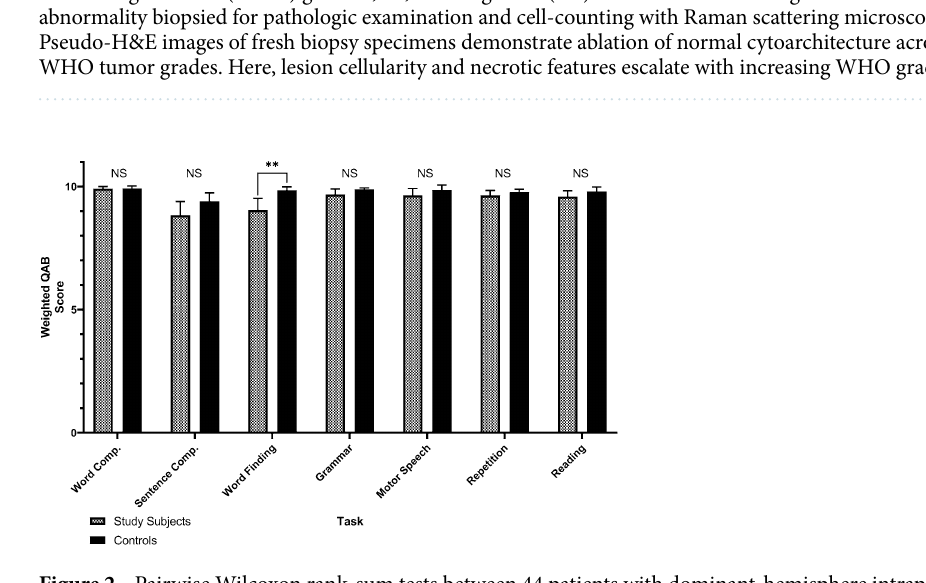
Figure 2. Pairwise Wilcoxon rank-sum tests between 44 patients with dominant-hemisphere intraparenchymal tumors (participants) and 36 patients with non-dominant tumors (controls) on each of the seven predefined Quick Aphasia Battery (QAB) subtests. ** P = 0.0096, corrected for multiple comparisons with the Holm- Bonferroni method. NS-not statistically significant ( P > 0.05). Word Comp.-word comprehension. Sentence Comp.-sentence comprehension. Grammar-grammatical construction. Error bars represent standard